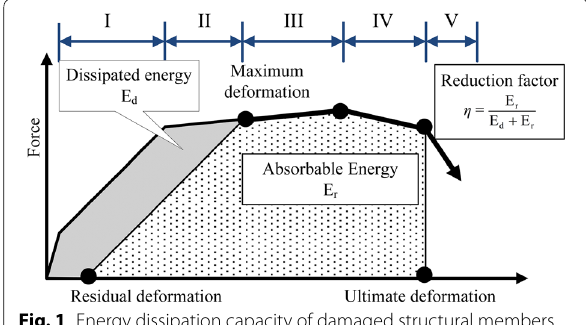
Fig. 1 Energy dissipation capacity of damaged structural